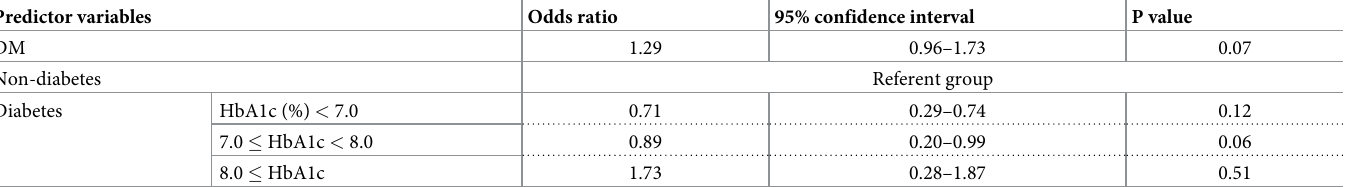
Table 3. Adjusted estimates of the post-operative complications.